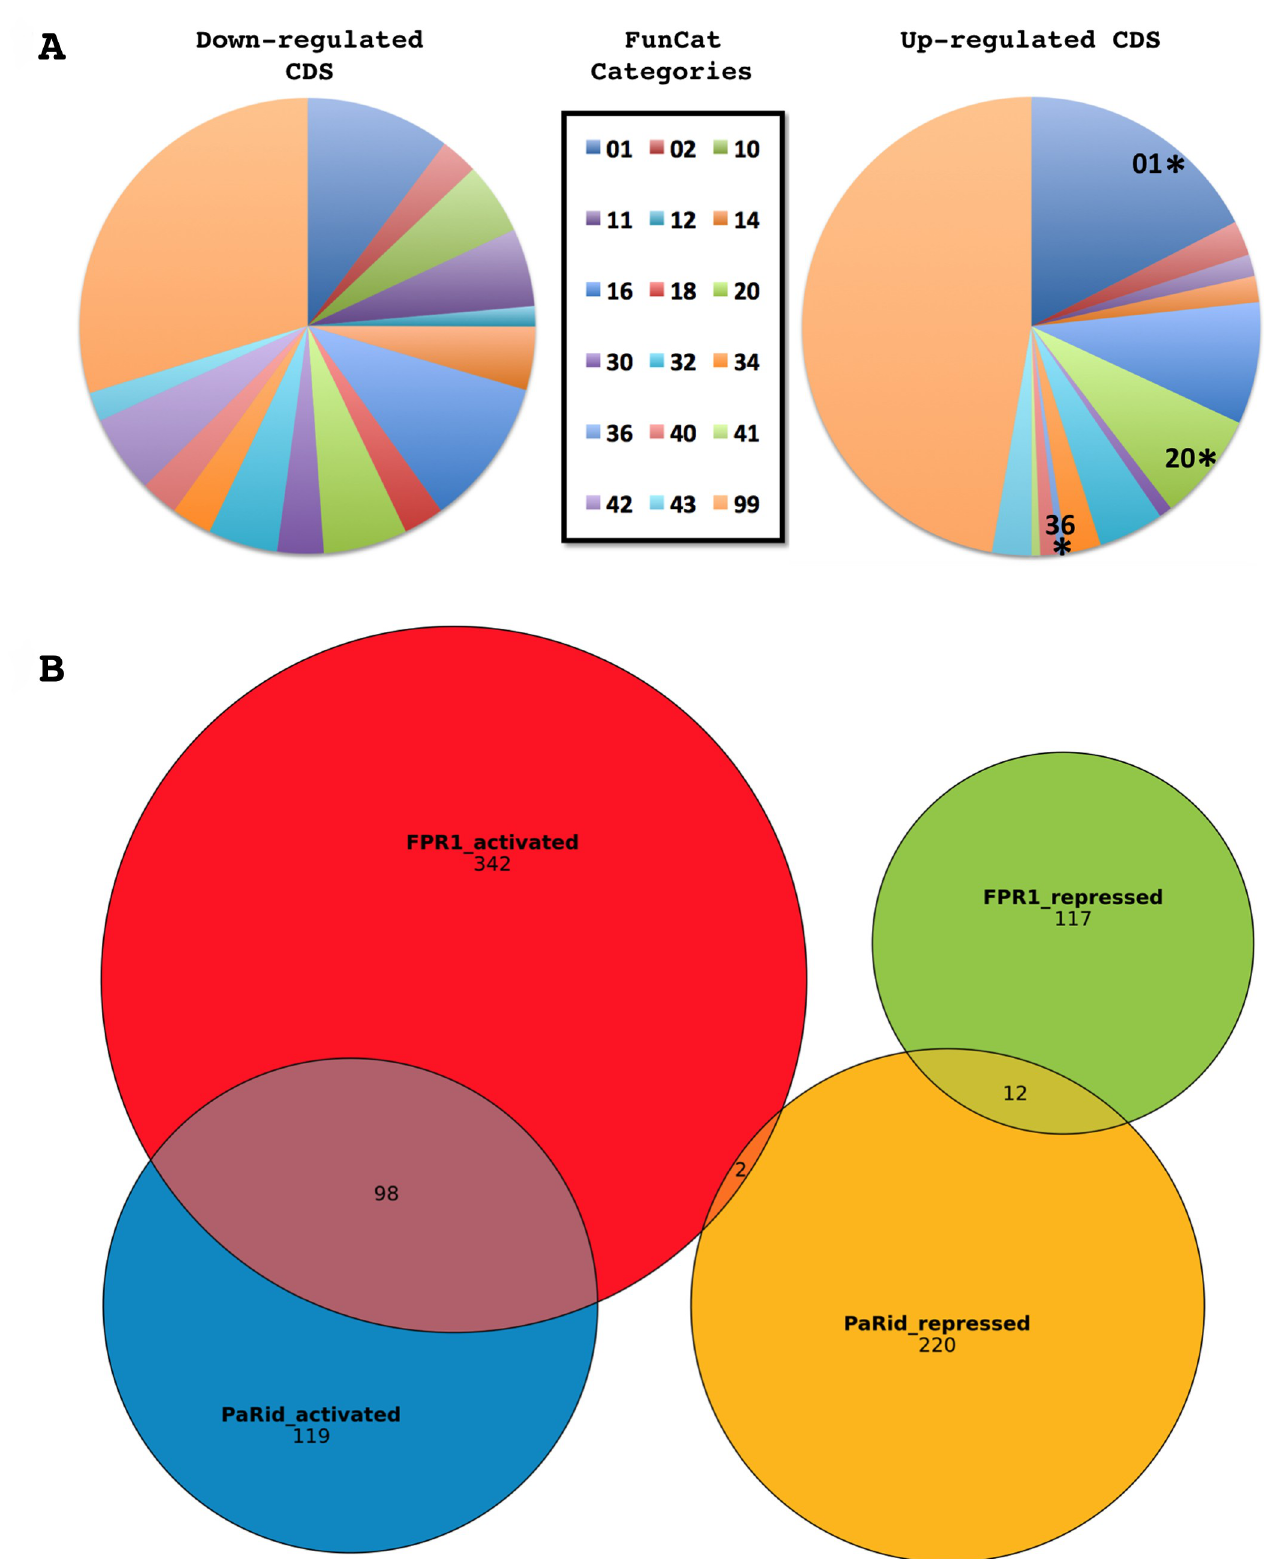
Fig 7. Transcriptomic analysis of differentially expressed CDS in response to Δ PaRid developmental arrest. (A) Functional categories in the down- and up-regulated CDS sets. Legend of pie charts corresponds to the FunCat categories, see Table 2 for details. Stars mark significantly enriched functional categories (p-value < 0.05). ( B ) Venn diagram of PaRid and FPR1 targets. https://doi.org/10.1371/journal.pgen.1008086.g007 PLOS Genetics | https://doi.org/10.1371/journal.pgen.1008086 August 14,